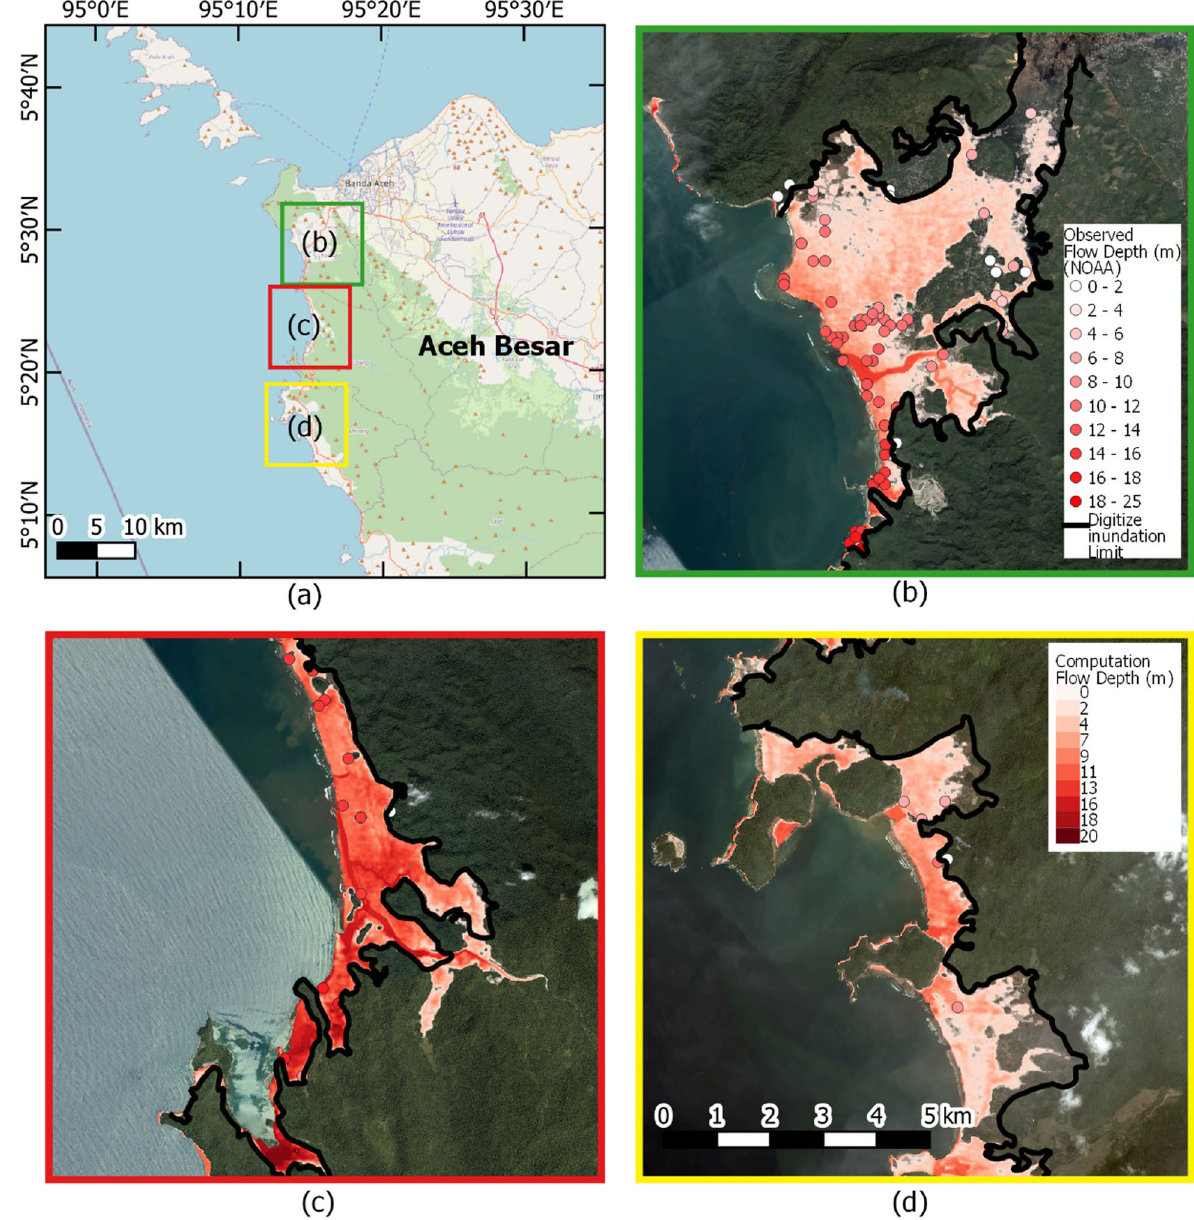
Fig. 4 a Location of observed flow depth from NOAA and digitizing tsunami limit. b , c overlay between NOAA observed data, digitized tsunami limit after tsunami 2004 (January 2005) from Google Earth, and computation flow depth for the 2004